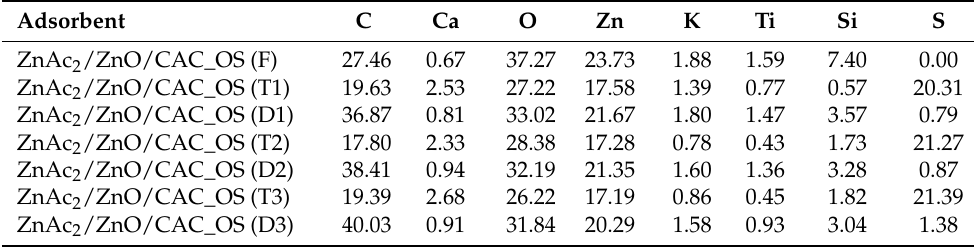
Table 4. Element contents of the ZnAc 2 /ZnO/CAC_OS surface in three cycles of H 2 S adsorption–